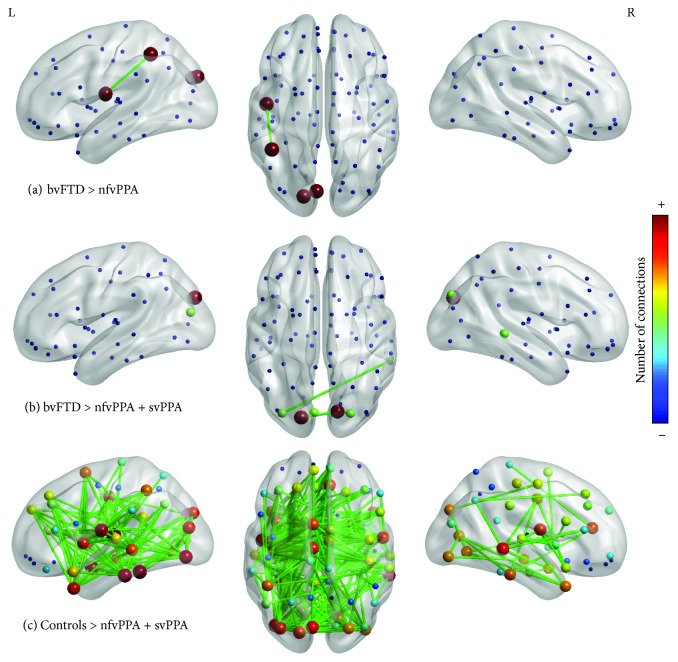
NBS results between FTD variants and controls.